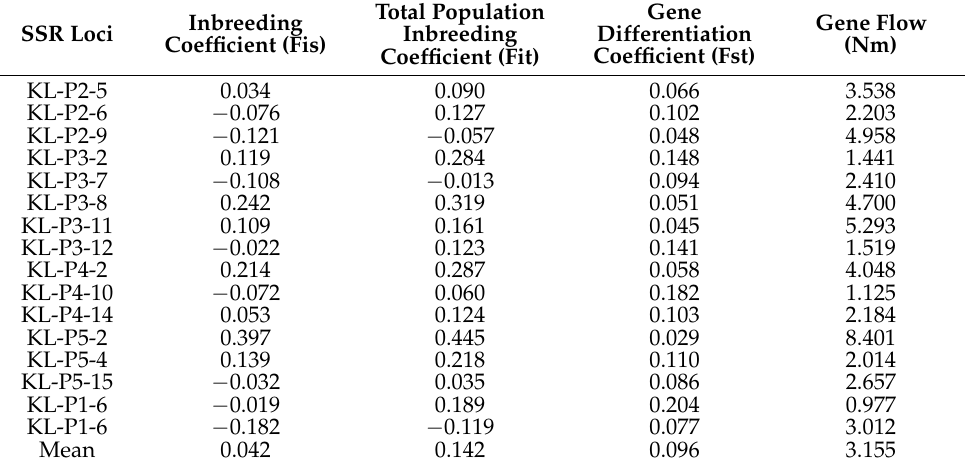
Table 4. F-statistics of genetic differentiation and gene flow of 16 SSR locus of M. azedarach .